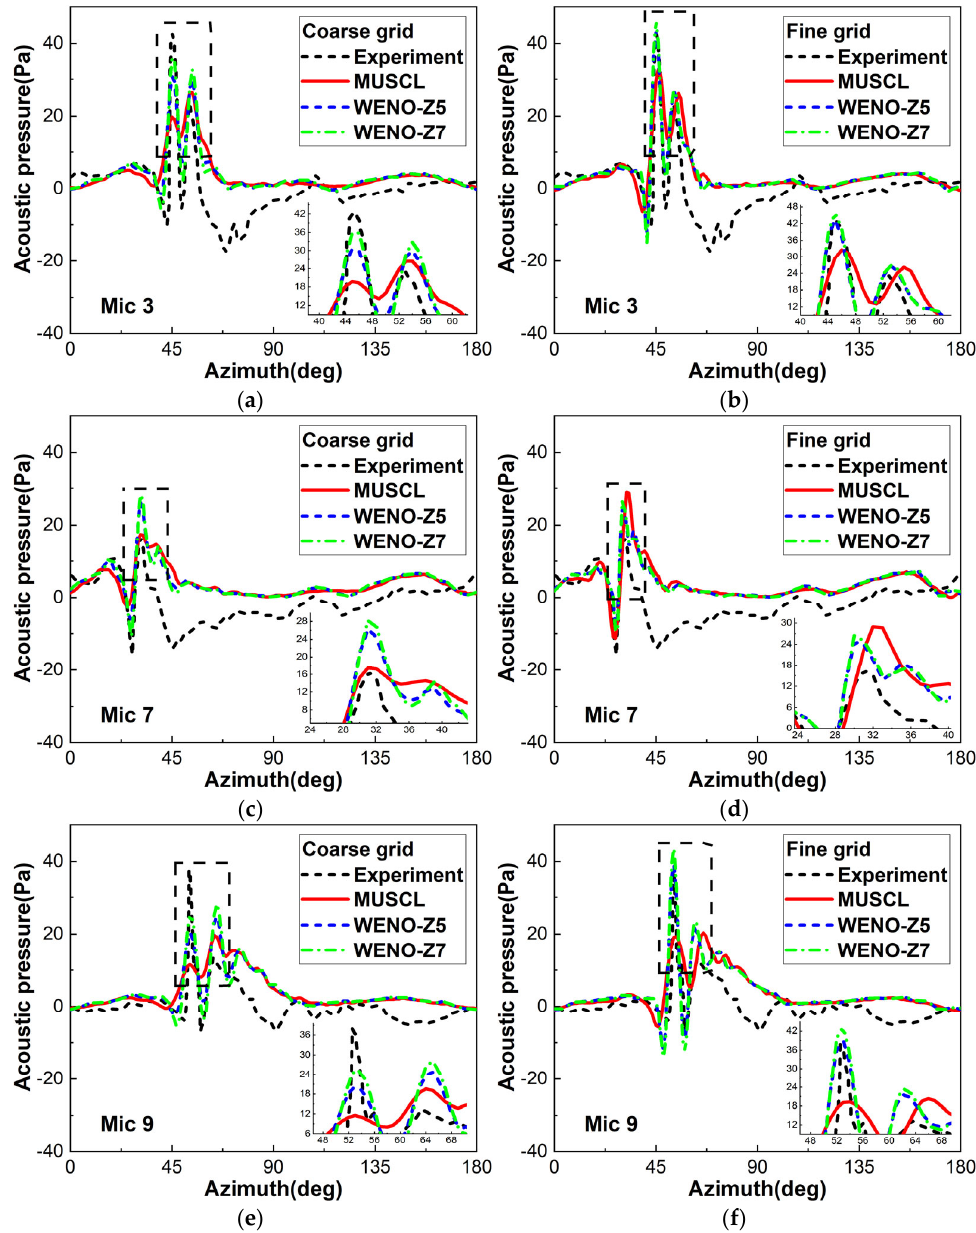
Figure 10. The BVI noise pressure time history of the OLS rotor for the WENO-Z and the MUSCL schemes for the coarse and fine grids: ( a ) Microphone 3 (coarse grid); ( b ) microphone 3 (fine grid); ( c ) microphone 7 (coarse grid); ( d ) microphone 7 (fine grid); ( e ) microphone 9 (coarse grid); ( f ) microphone 9 (Fine grid).